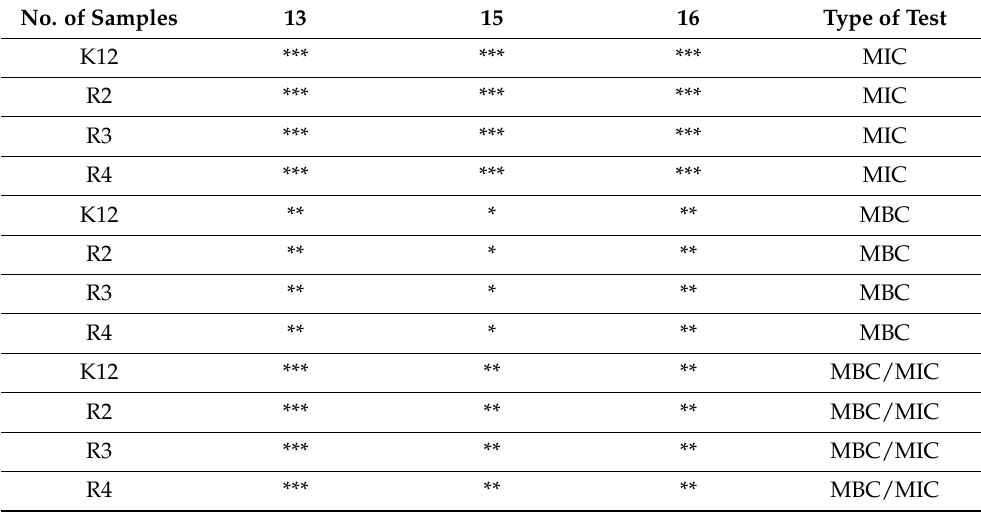
Figure 5. The ratio of MBC/MIC of the phosphonate derivatives. The x -axis features compounds 1 – 16 used sequentially. The y -axis shows the MIC value in µg/mL − 1 . Investigated strains of E. coli K12 as control (blue), R2 strains (orange), R3 strains (grey), and R4 strains (yellow). The order in which the compounds were applied to the plate is shown in Supplementary Materials Figure S1. Table 2. Statistical analysis of all analyzed compounds by MIC, MBC, and MBC/MIC; <0.05 *, <0.01 **, <0.001 ***.